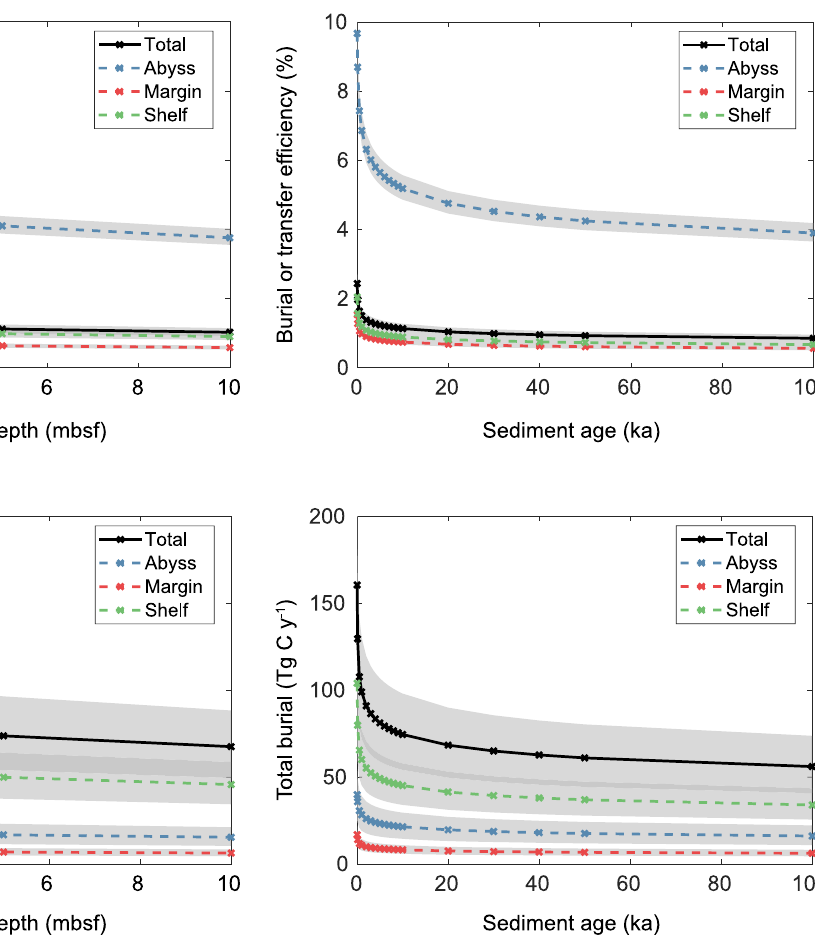
Fig. 3 | Transfer and burial of organic carbon (OC) in marine sediments according to sediment depth and sediment age. a Global maps of transfer ef fi - ciencyfromthesediment-waterinterface(SWI)to1mbsf( T eff,depth (SWI → 1mbsf),%) andfromtheSWIto 0.1ka( T eff,age (SWI → 0.1ka),%). b Transfer(orburial)ef fi ciency